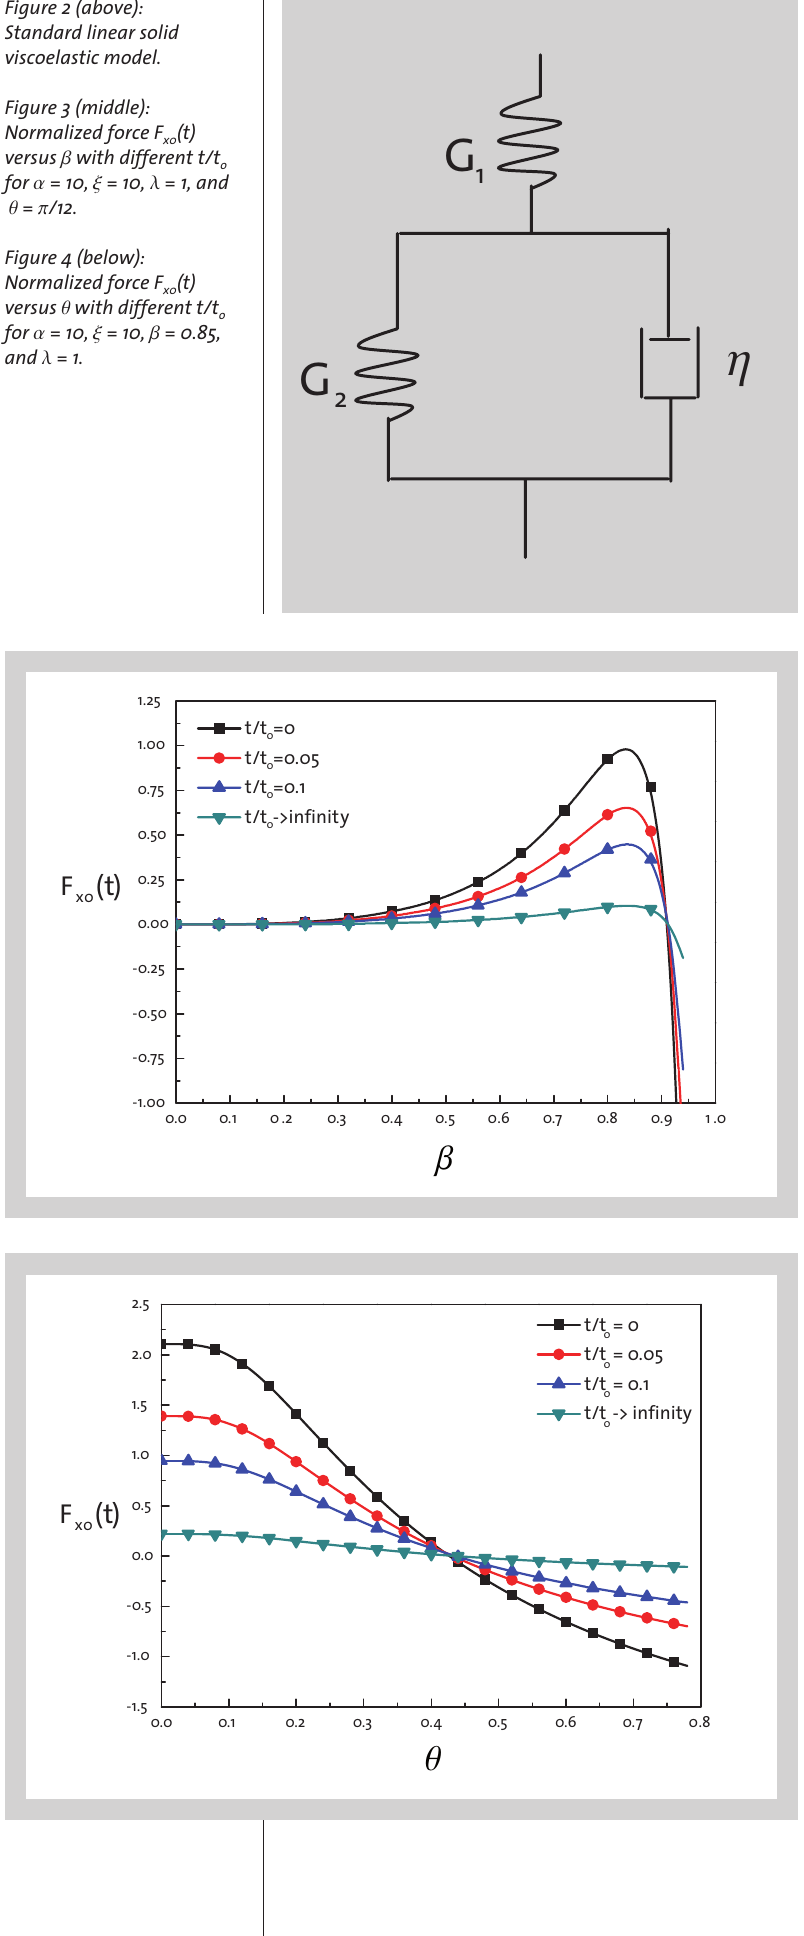
calculating the Laplace inverse transformations